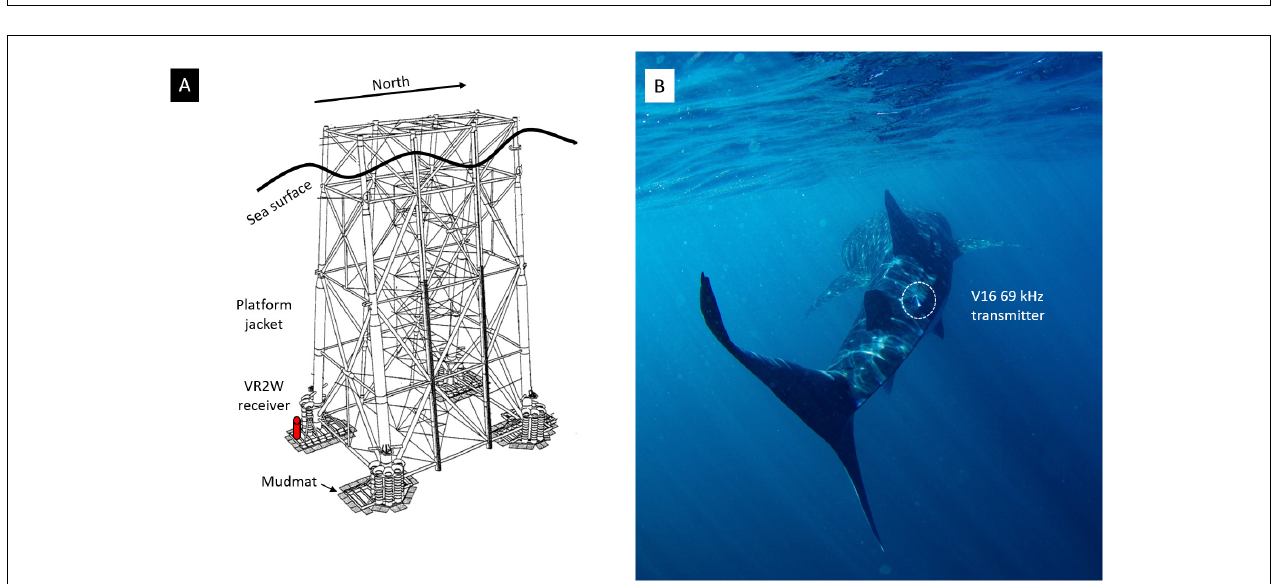
FIGURE 2 | (A) A stylised platform jacket showing approximate placement of a VR2W receiver (in red) on a mudmat at the base of the jacket and (B) a whale shark tagged with a V16 69 kHz acoustic transmitter (within dashed circle) pictured at Ningaloo Reef (picture by R. Pillans).